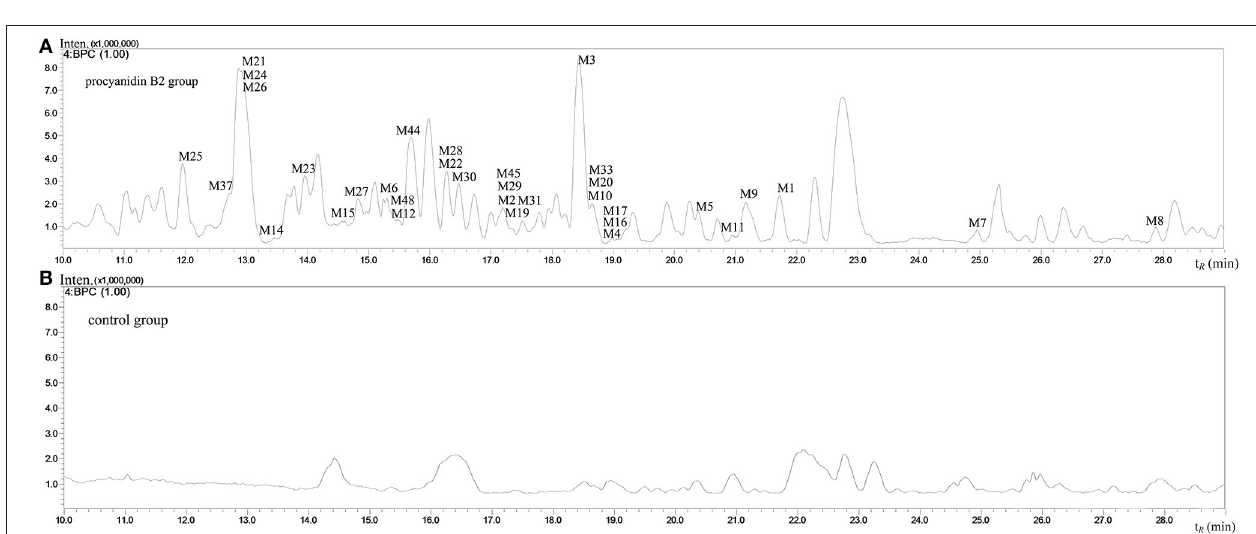
FIGURE 2 | MS 2 fragmentation data obtained in negative ion detection mode of procyanidin B2 and ( − )-epicatechin.